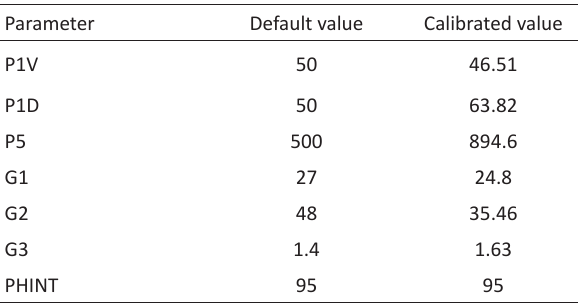
Table 4. Genetic coefficients fitted for the cultivar